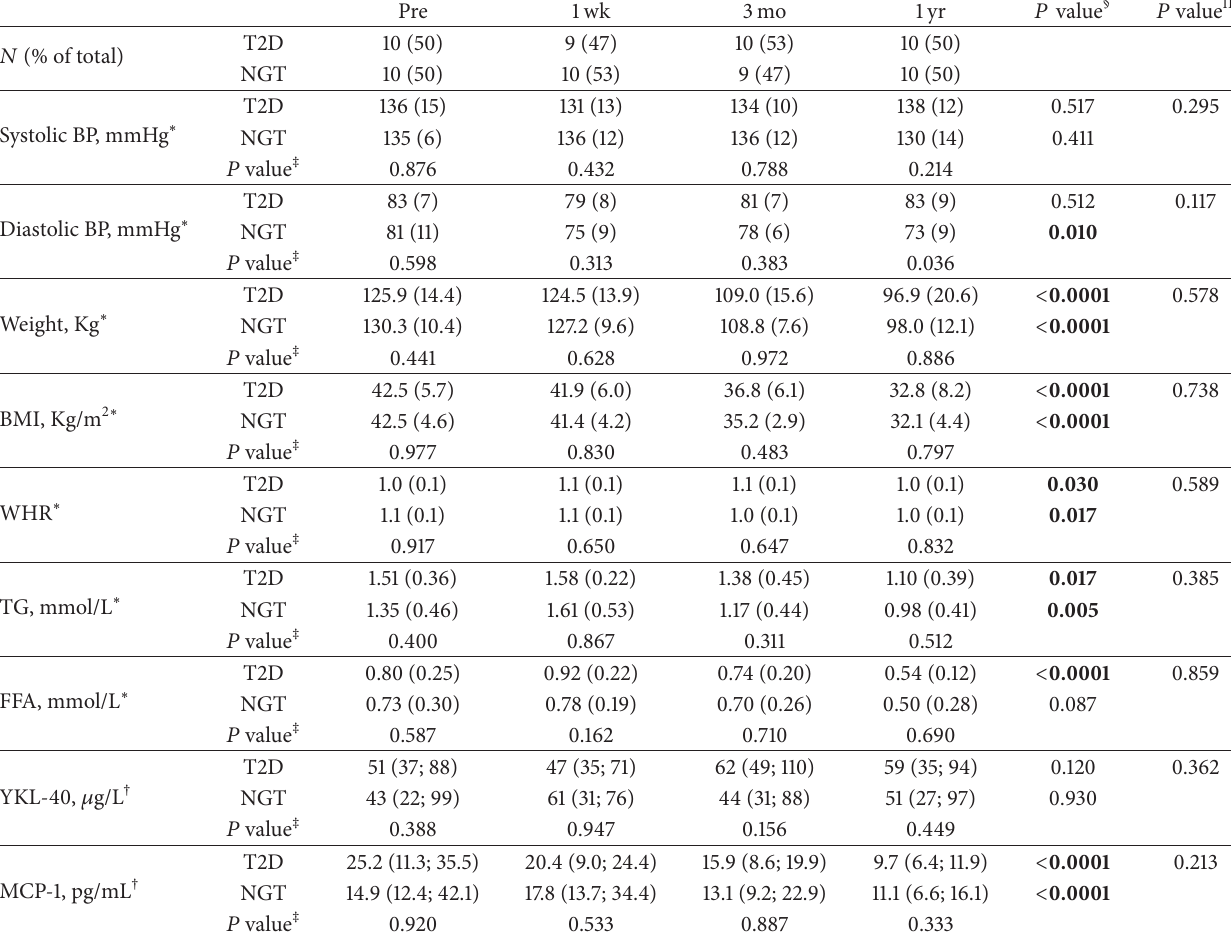
Table 1: Clinical characteristics, lipids and inflammatory markers in subjects with type 2 diabetes, and normal glucose tolerance before (pre) and 1wk, 3mo, and 1yr after Roux-en-Y gastric